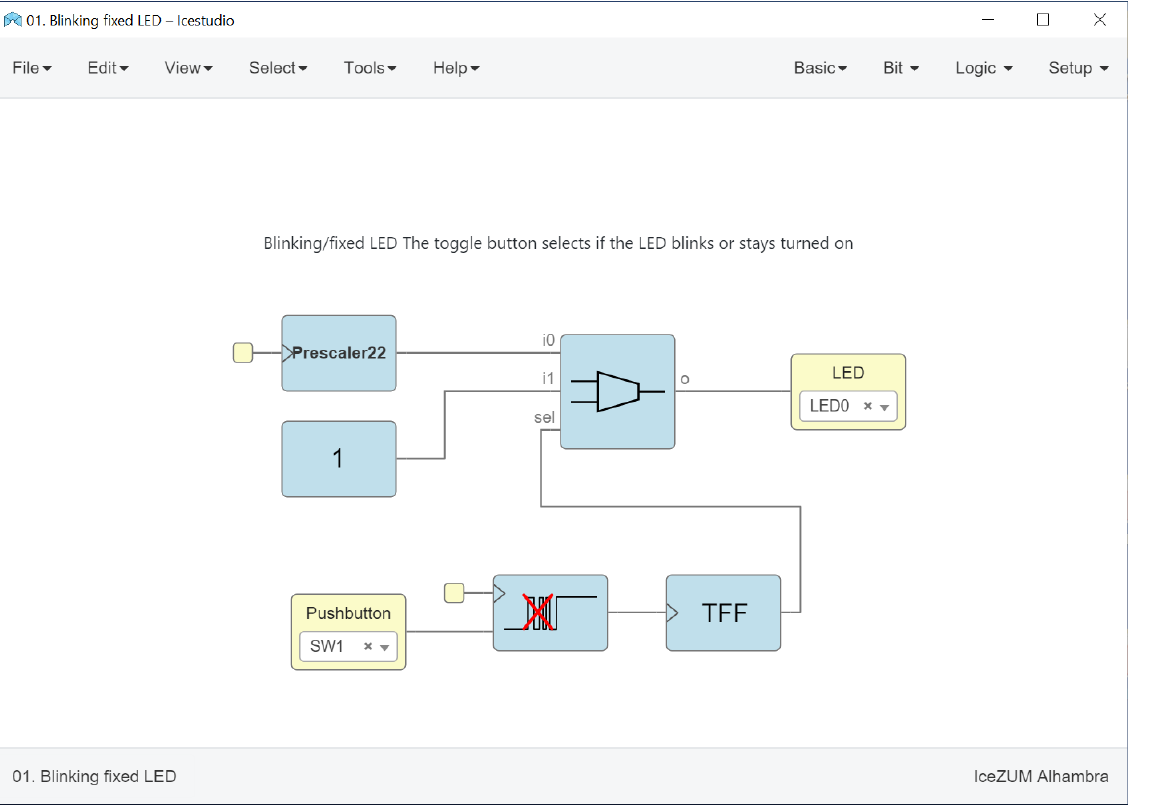
Figure 3. Circuit design example using Icestudio visual